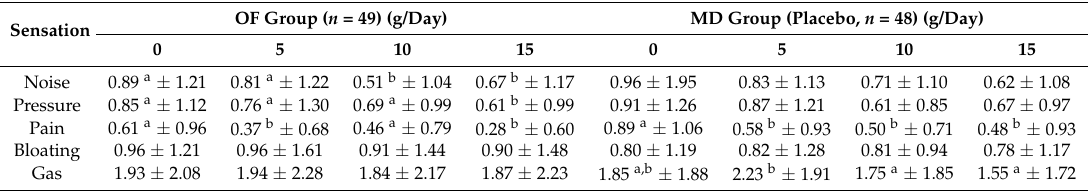
Table 2. Gut sensations (means and standard deviations) on a 0 to 10 scale reported by participants assigned to the oligofructose group + supplemental OF or the MD group (placebo) during each of the